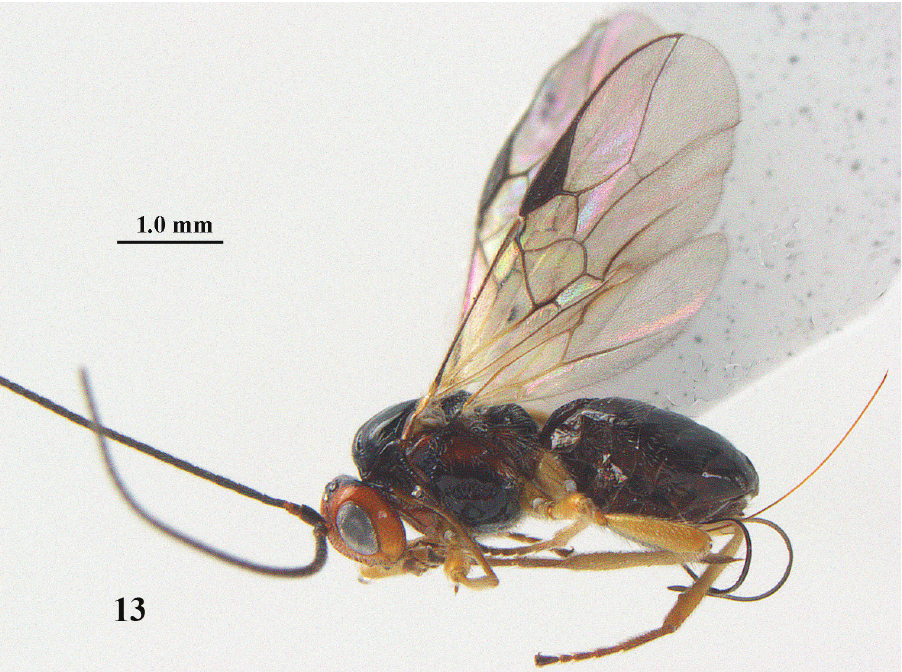
Figure 13. Psyttalia cyclogaster (Thomson), ♀ , China, Ningshan, habitus